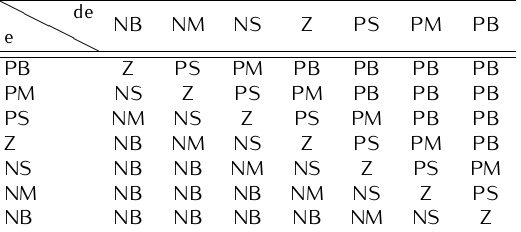
Table 1. Rule bases for the fuzzy PD component.